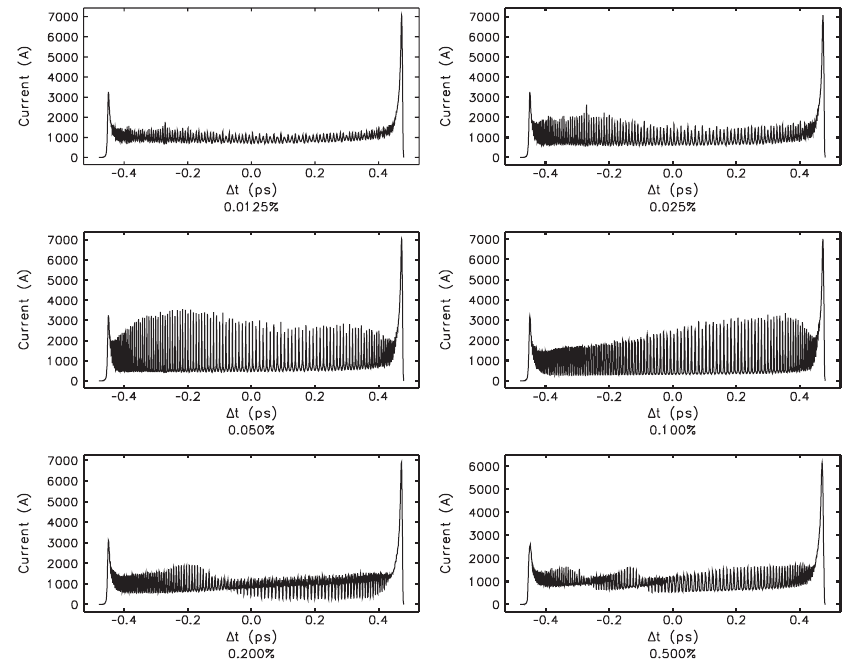
FIG. 7. Final longitudinal density for FERMI for 30 (cid:1) m initial modulations of various